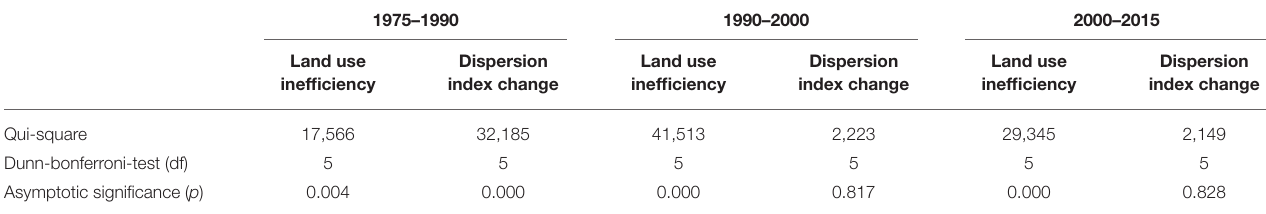
TABLE 3 | Results of the Kruskal-Wallis-test (continents).